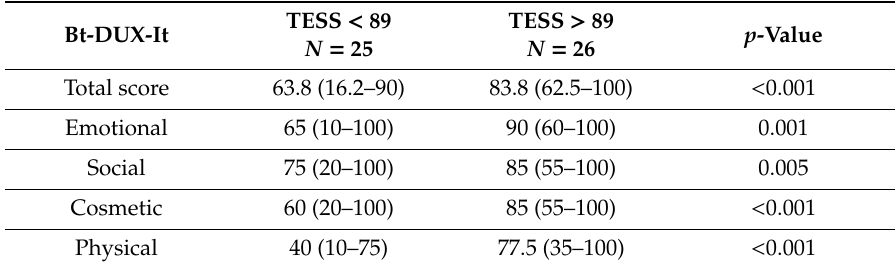
Table 4. Bt-DUX total and domain scores in groups of patients with worse and better functional (TESS)